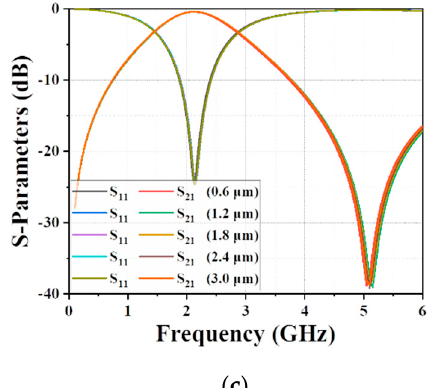
Figure 6. The effect of varying the metal thickness of the leads and bond layer on ( a ) S11 and ( b ) S21; ( c ) the effect of varying the metal thickness of the text layer.